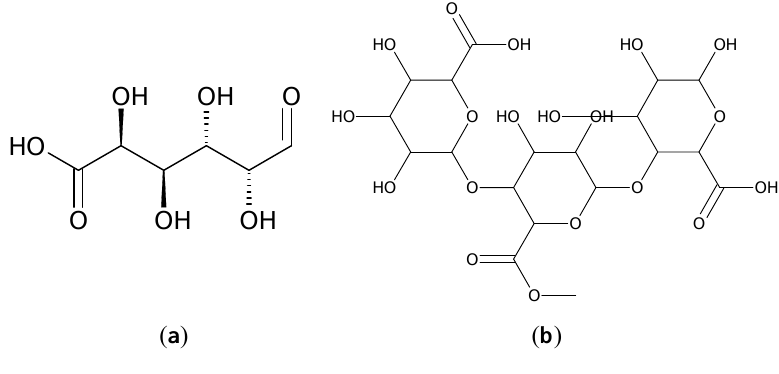
Figure 1. Pectins consist if ( a ) galacturonic acid and ( b ) methylesterified homogalacturonan (see the text for details)